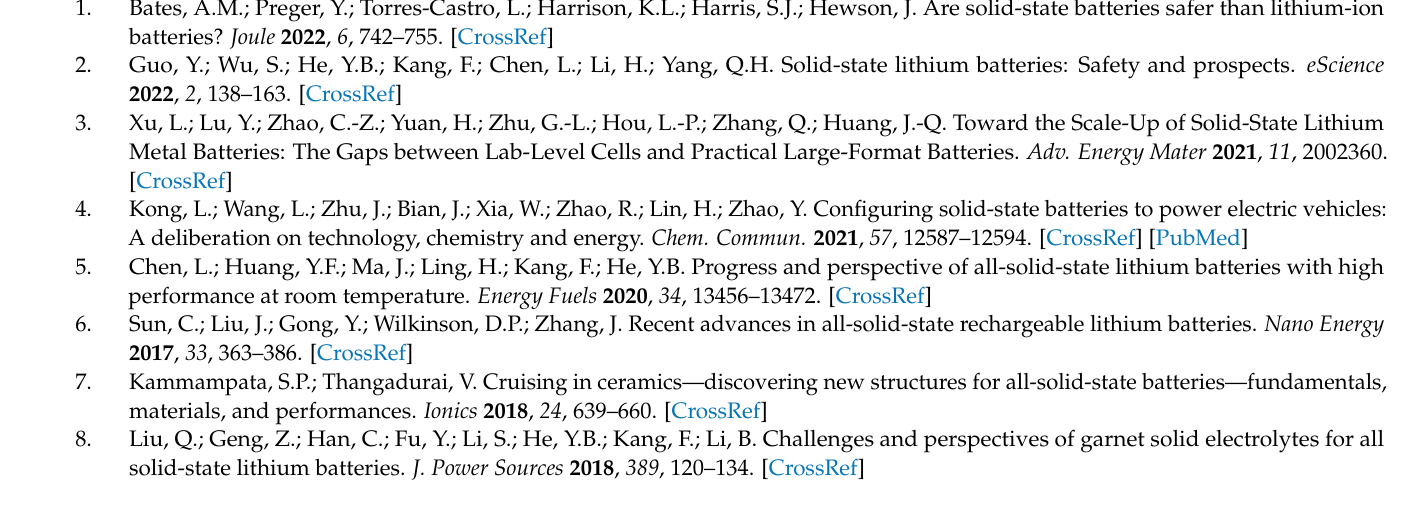
Table S1: The fitting results of impedance plots at Figure 4b; Figure S3: Cyclic voltammetry curves for (a) Li-In (18 at% Li)|LLZcomp|Li-In (18 at% Li) and (b) Li|LLZcomp|Li cells with at scanning rate of 10 mV